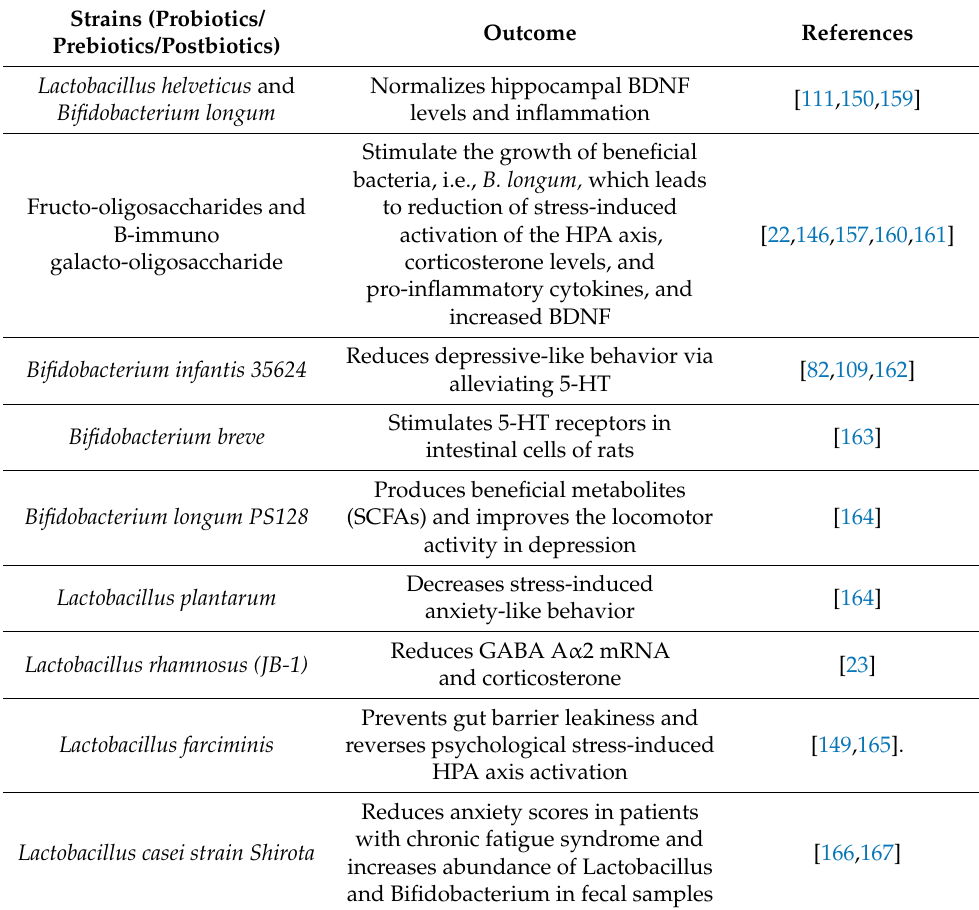
Table 1. Examples of probiotics, prebiotics, and postbiotics used to treat anxiety- and depressive-like